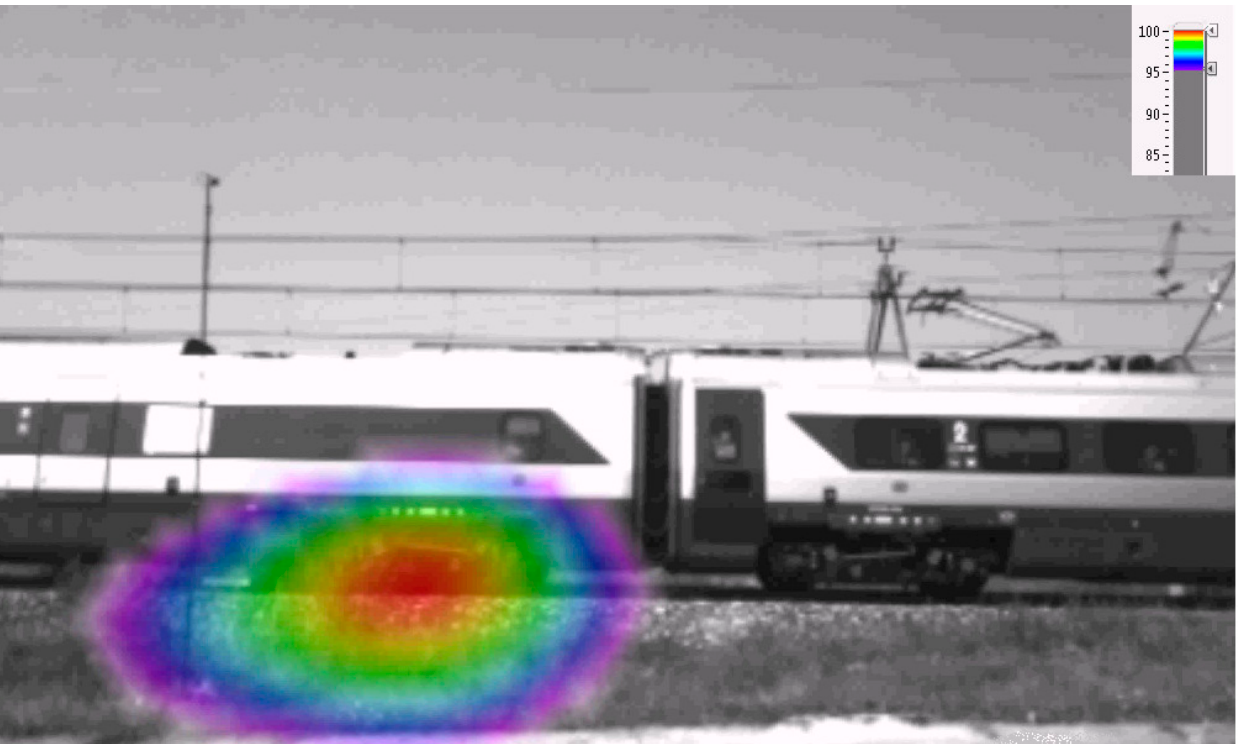
Figure 12. Sound level distribution within a frequency range of 2000–3000 Hz—straight section .